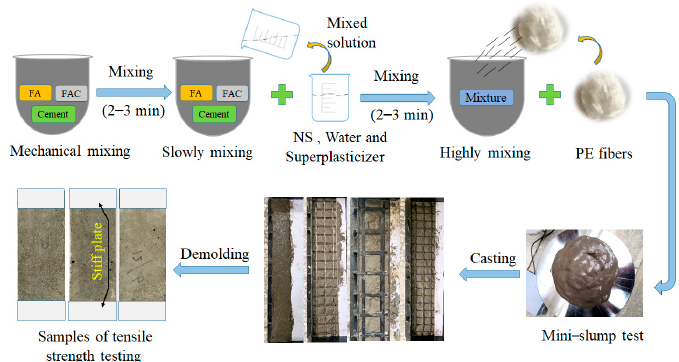
Figure 2. Flowchart of specimen preparation. Note: FA, fly ash; FAC, fly ash cenospheres; NS,